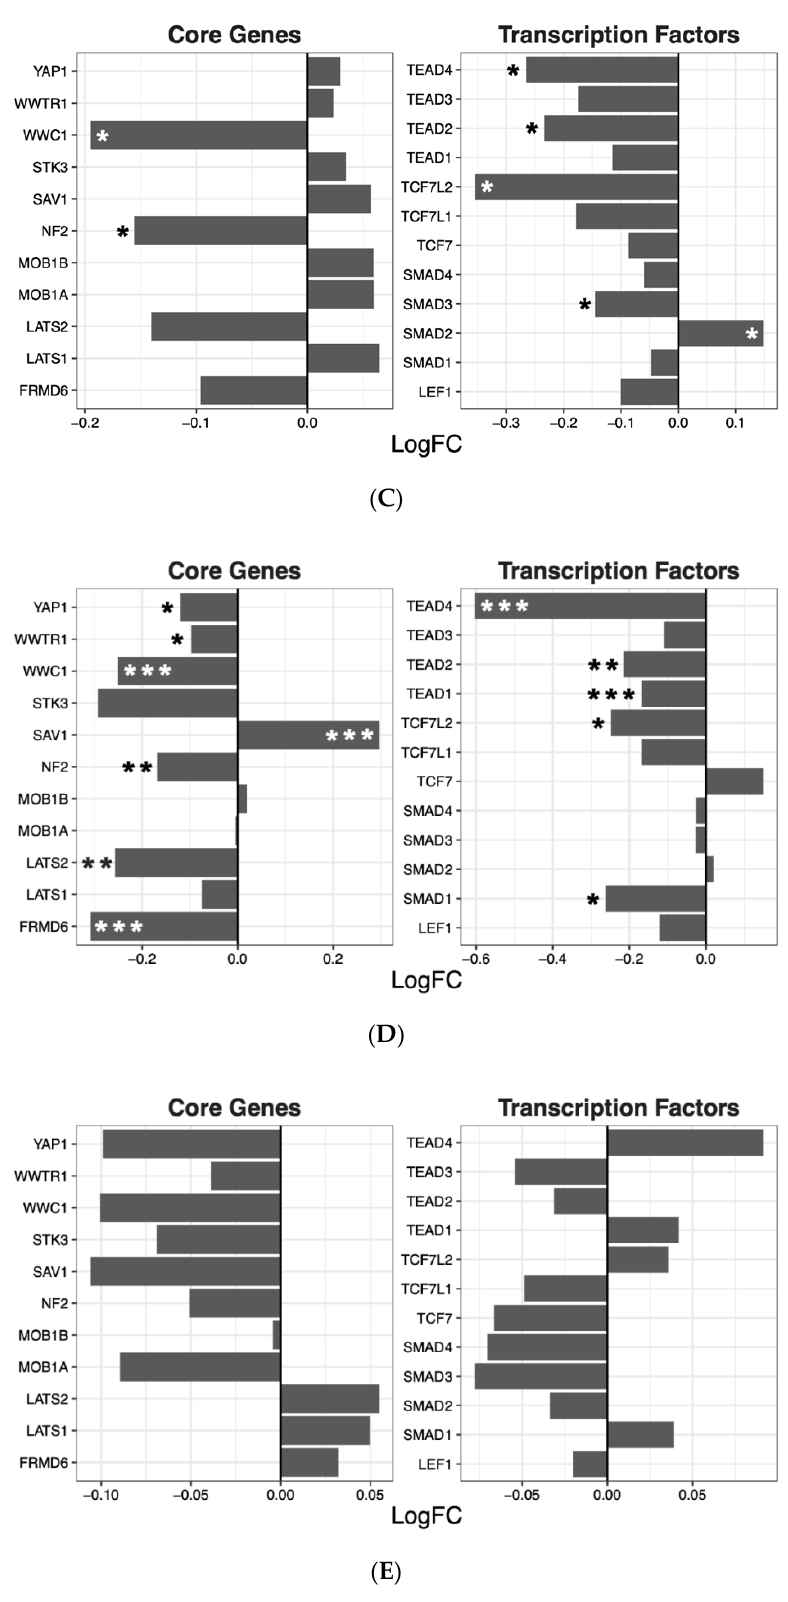
Figure 1. Effects of five drugs in the core genes and transcriptional factors of the Hippo pathway. ( A ) Amisulpride. ( B ) Aripiprazole. ( C ) Clozapine. ( D ) Quetiapine. ( E ) Risperidone * p < 0.05, ** p < 0.005, and *** p < 0.001.